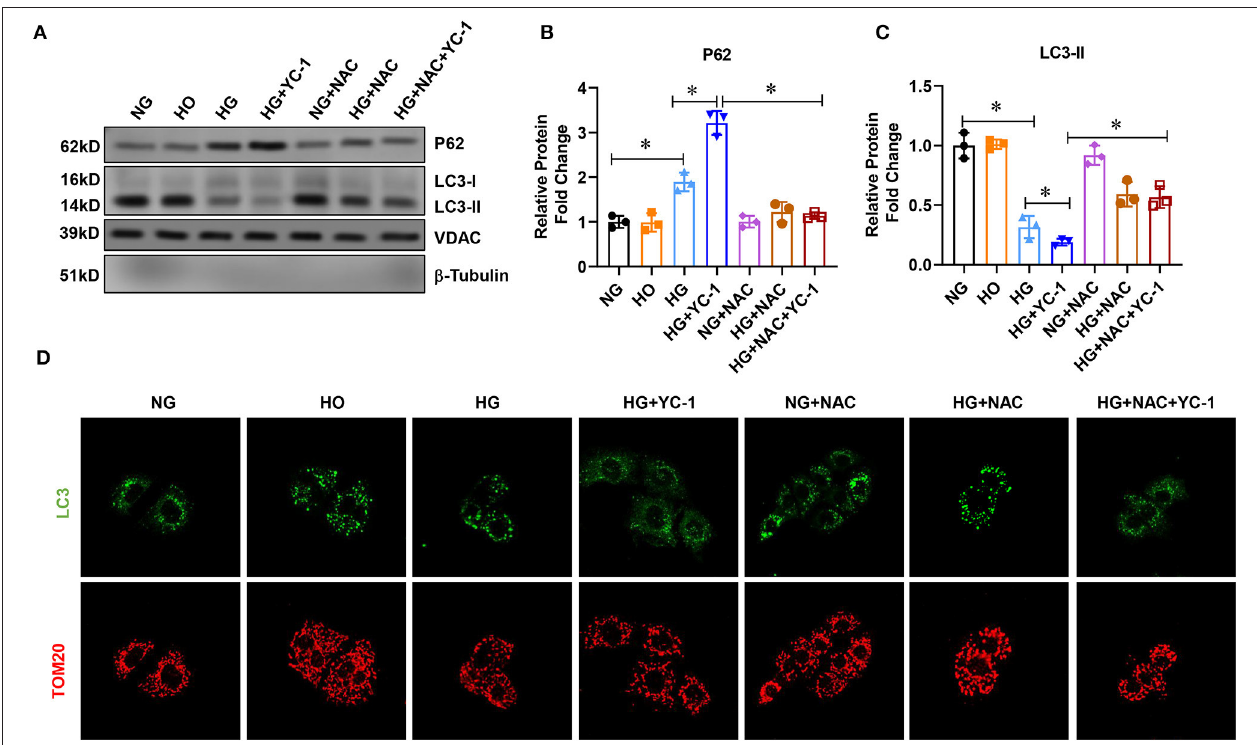
FIGURE 1 | Effect of HIF-1 α on mitophagy-related proteins in HK-2cells subjected to HG exposure. (A–C) . The expression of p62 and LC3-II was assessed by Western blot in HK-2 cells treated with normal glucose, high-glucose for 24h with or without 10 µ M HIF-1 α inhibitor YC-1, and reactive oxygen species (ROS) scavenger N-Acetyl-L-Cysteine (NAC) at a final concentration of 5mm.* p < 0.05. vs. indicated group. (D) Mitophagy was assessed using a fluorescence confocal microscope. HG, High Glucose; LC3-II, Microtubule-Associated-Proteinlight-Chain-3 II; HIF-1 α , Hypoxia-Inducible Factor-1; YC-1, Lificiguat; ROS, Reactive Oxygen Species; NAC,